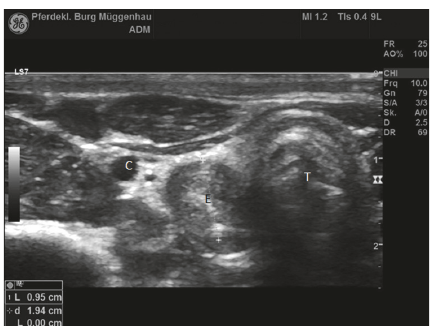
Figure 2: Ultrasound image of the esophagus cranial to the esophageal stricture. Esophageal diameter is 9,5 mm. Left in the image is dorsal. C: carotid artery. E: esophagus. T: trachea (probe frequency 10 MHz, depth 2,5 cm).